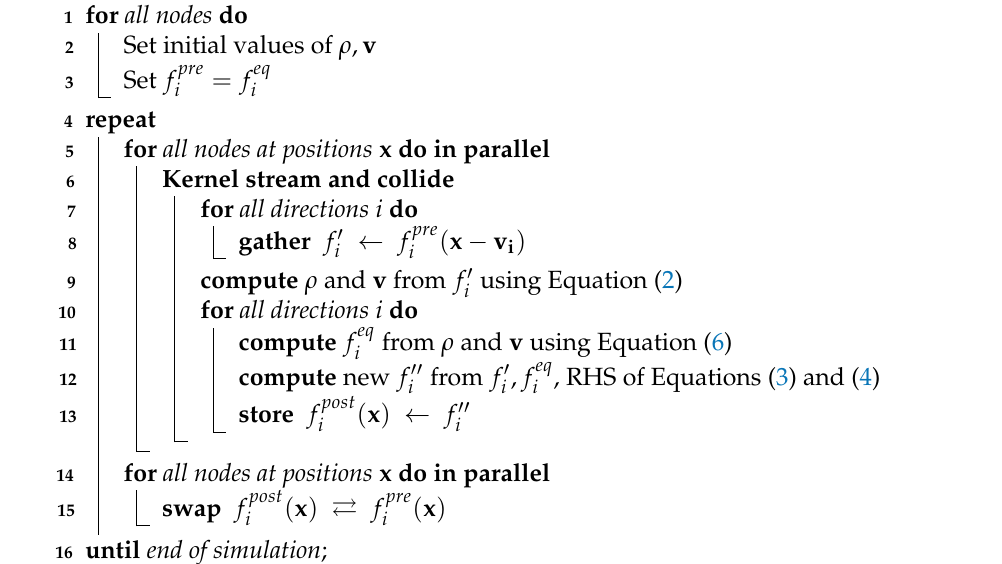
Algorithm 1: General idea of the presented LBM implementation. ρ , v , f (cid:48)